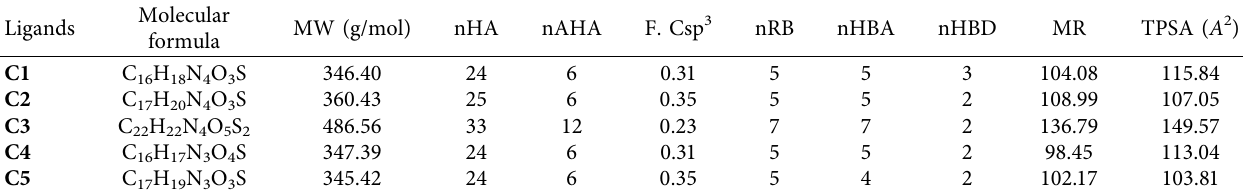
Table 2: Te physicochemical property of TZDs derivatives calculated with swissADME database.